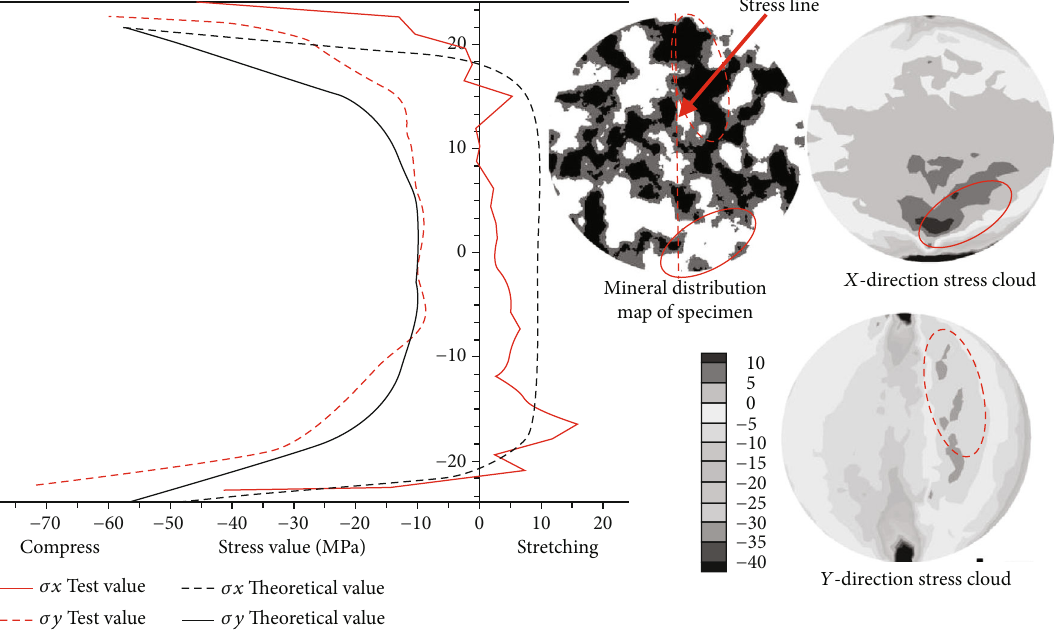
Figure 9: Schematic diagram of stress distribution along the loading